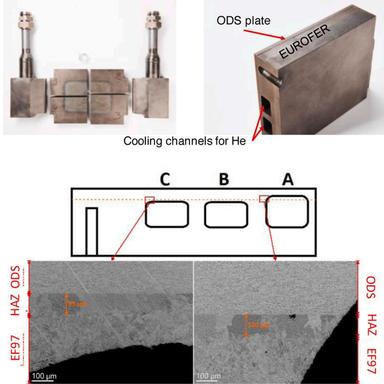
ODS-EUROFER FW mockup cut up after testing and SEM analysis at the interface of the HIP joint – transition from ODS plating (thickness=3mm) via the heat affected zone (HAZ) to EUROFER97 (thickness=20.5mm); total size of ODS plated area: 200×160×23.5mm.